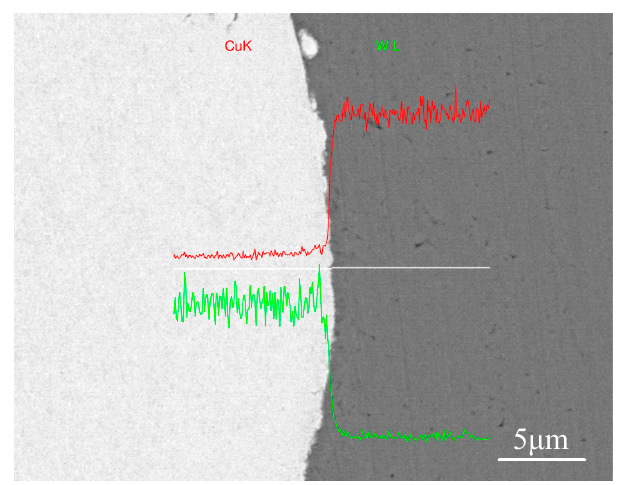
Figure 8. Optical microstructure of the etched W–Cu interface of T-6.